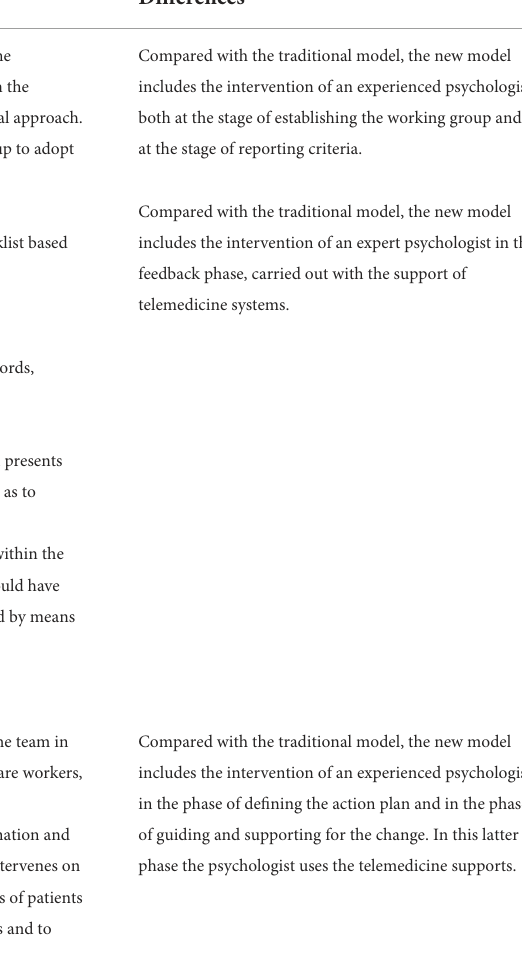
TABLE 1 Traditional A&F procedures and the new A&F model and their differences. Traditional